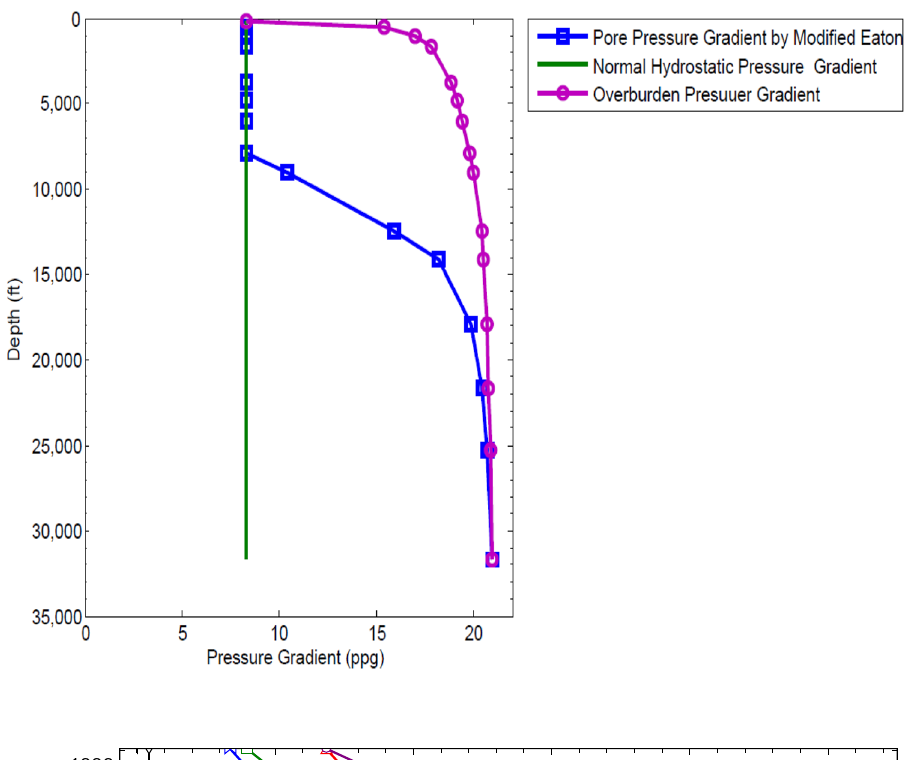
Fig. 18 Fracture pressure